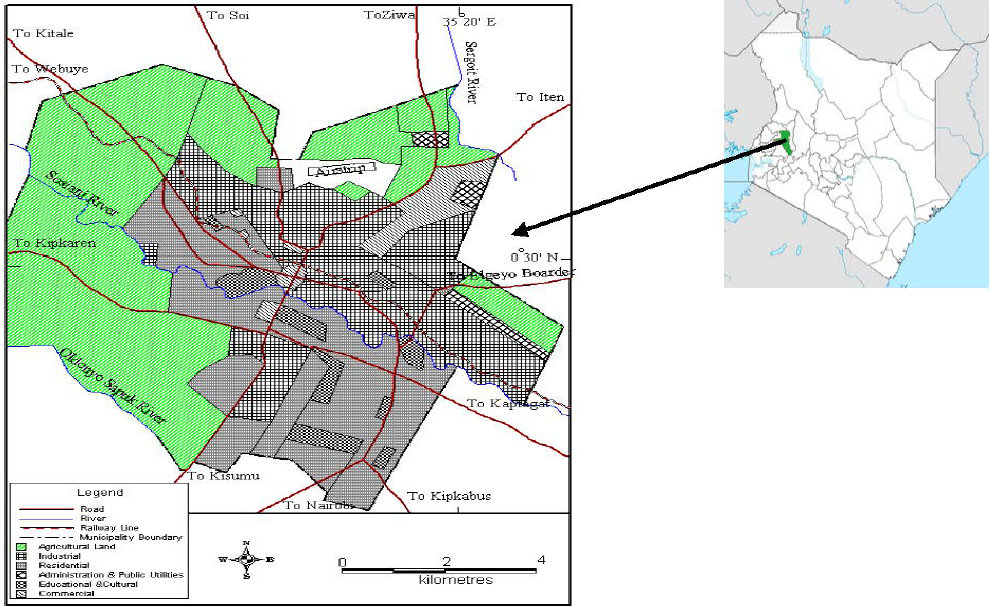
Figure 2. Location of Eldoret Municipality study area, Kenya as